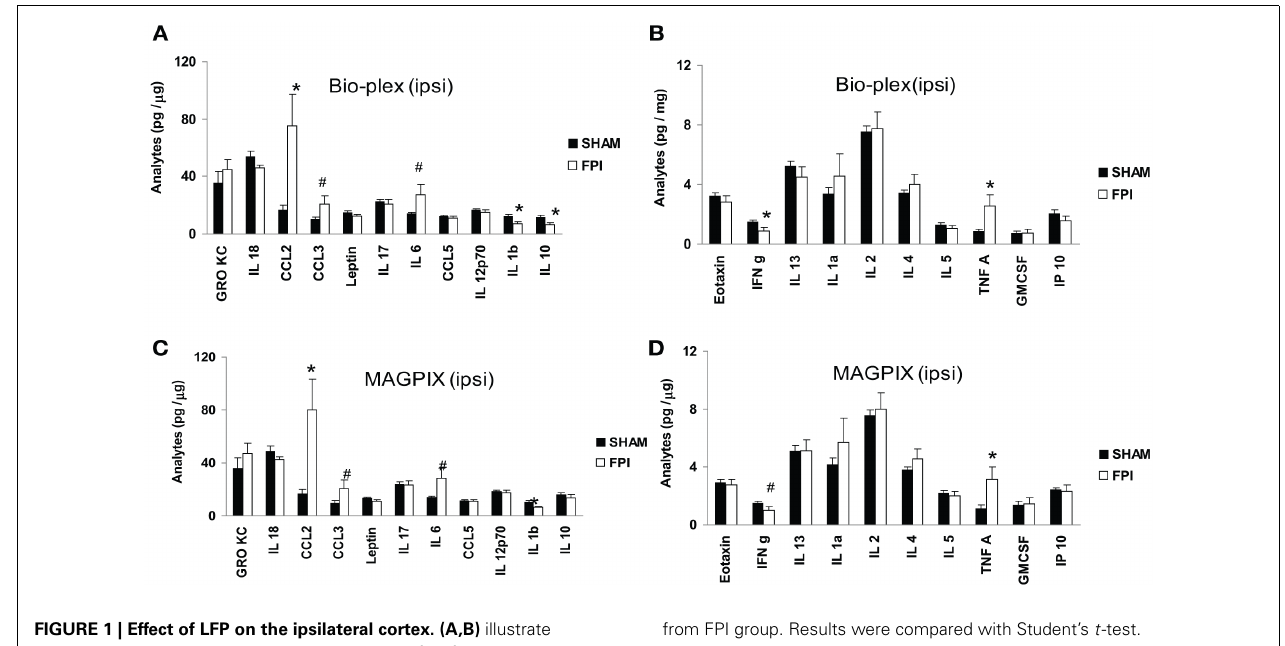
FIGURE 1 | Effect of LFP on the ipsilateral cortex. (A,B) illustrate the results generated by the Bio-Plex instrument. (C,D) illustrate the results generated by the MAGPIX instrument. Black filled bars denote the value from sham group.The white bars denote the value